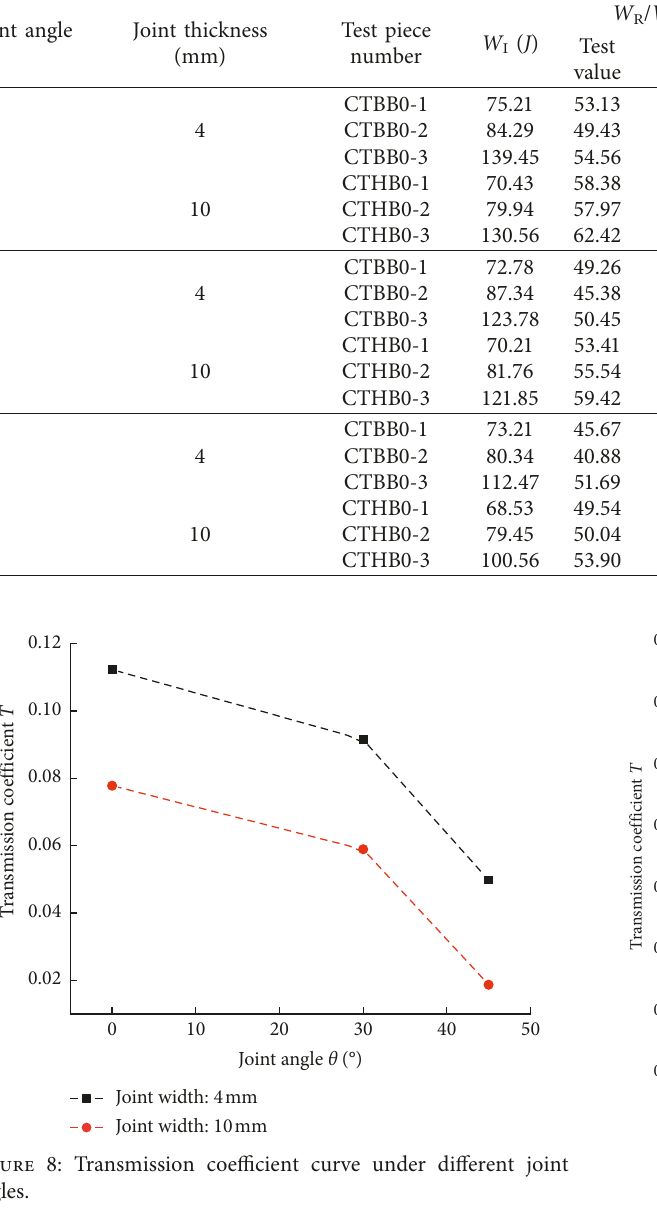
Table 3: Statistics of energy ratio and energy dissipation of filled joint rock sample. Joint angle